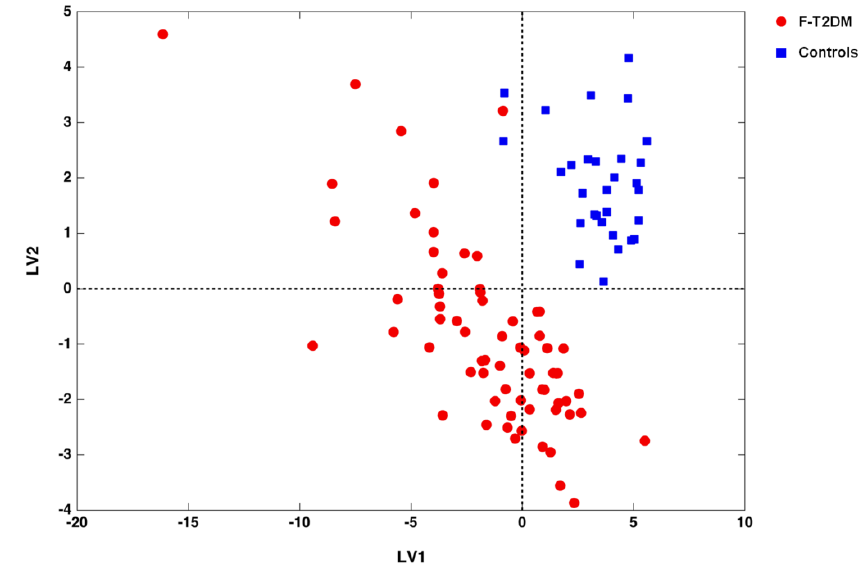
Figure 1. Scores plot showing the separation of frail/pre-frail older adults with type 2 diabetes mellitus (F-T2DM) from control participants according to the serum concentrations of amino acids and derivatives in the space spanned by the two latent variables (LV1 and LV2), as determined by partial least squares-discriminant analysis.